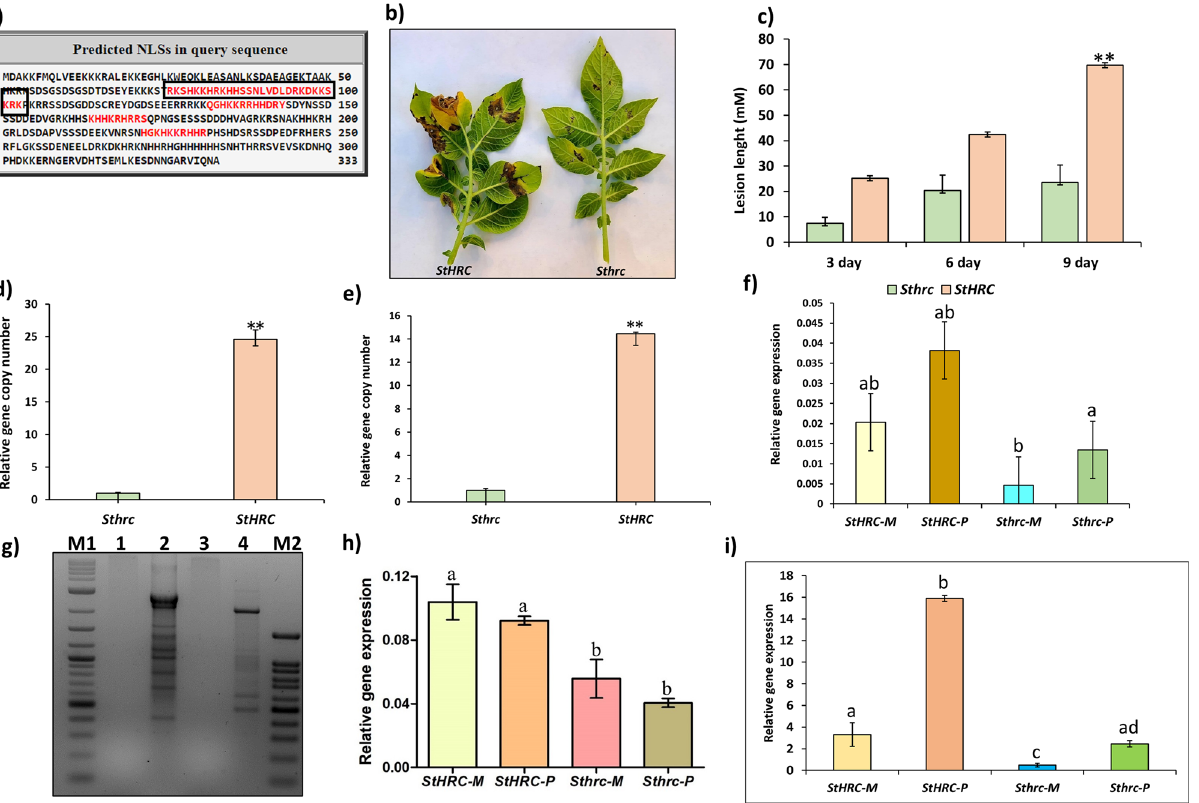
Figure 2. Russet Burbank potato plants, possessing functional and mutated histidine rich Ca 2+ binding protein ( StHRC or Sthrc ), inoculated with P. infestans . ( a ) StHRC gene sequence with CaM protein binding site, NSCaTE. ( b ) late blight disease symptoms in RB potato with StHRC and Sthrc ; ( c ) disease progress on stem, based on lesion diameter, in RB potato with StHRC and Sthrc , inoculated with P. infestans. ( d ) pathogen biomass in the diseased area of stem; ( e ) pathogen biomass in the diseased area of leaf; ( f ) relative gene expressions of StHRC and Sthrc , in RB, inoculated with P. infestans; ( g ) DNA laddering in RB potato inoculated with P. infestans , M is DNA ladder, M1 is 100 bps and M2 is 1 kb, 1 = StHRC Mock, 2 = StHRC Pathogen, 3 = Sthrc Mock, 4 is Sthrc pathogen inoculated ; ( h ) Gene expression of StCAN2 in RB plants, with StHRC and Sthrc , following inoculation with P. infestans; ( i ) Gene expression of StMC7 in RB plants, with StHRC and Sthrc , following inoculation with P. infestans . Significance calculated based on Student’s t-test P value: **p < 0.01, *p < 0.05; or based on multiple comparison tests. Values are average of three Plants with functional HRC but not with the mutated ( hrc ) induced AL‑PCD. To prove that the functional HRC can induce AL-PCD, the DNA collected from spikelets of wheat NILs possessing functional and mutated alleles inoculated with F. graminearum were subjected to DNA laddering, which revealed distinct ladders in FHB susceptible wheat NIL possessing TaHRC but not in FHB resistant NILs possessing naturally mutated Tahrc (Fig. 1e). Similarly, the RB variety of potato plants with functional ( StHRC ) and silenced ( Sthrc ), based on CRISPR-Cas9 gene editing, inoculated with P. infestans and A. solani revealed DNA ladders only in plants possessing StHRC but not in silenced Sthrc (Figs. 2g; 3e). The inoculation of Thaxtomin A, a cellulose biosynthesis inhibiting toxin produced by S. scabiei , to protoplasts of RB potato plants with the functional StHRC induced AL-PCD, proved based on a terminal deoxynucleotidyl transferase dUTP nick-end labelling (TUNEL) assay, but the absence of Thaxtomin A failed to induce AL-PCD in protoplasts (Fig. 4b). Ca 2+ responsive metacaspases and endonucleases in RB potato and their role in AL‑PCD. The hallmarks of AL-PCD are the plasma membrane breakdown and apoptotic-like DNA fragmentation. The cyto- plasm shrinkage and membrane breakdown in plants is induced by metacaspases. The Solanum tuberosum meta- caspase gene ( StMC7 ), revealed a significantly higher gene expression in both P. infestans and A. solani inocu- lated RB-plants with StHRC relative to Sthrc , and also was significant in pathogen inoculated relative to mock (Fig. 2i) and A. solani (Fig. 3g). An ortholog of the AtCaN2 in potato genome, belonged to clade-I among the IV clades was identified in potato, designated as StCaN2 (Fig. S1e). When inoculated with P. infestans the DGE of StCaN2 was significantly higher in StHRC relative to Sthrc but not significant between the mock and the patho- gen inoculated (Fig. 2h). Whereas when inoculated with A. solani the DGE was significant higher in StHRC than in Sthrc , and also in Sthrc pathogen inoculated than in mock, but not in StHRC (Fig. 3f).